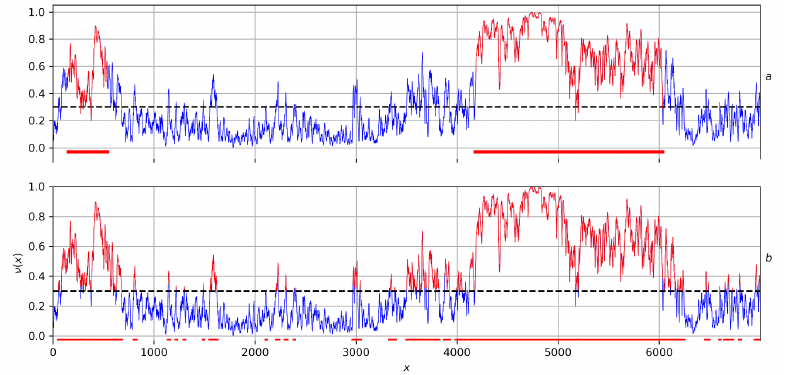
Figure 11. Operation of the FDPS algorithm on a regular grid ( a ). The FDPS algorithm results in two red lines on the horizontal axis, which serve as the bases of the two most significant stochastic heights. Figure ( b ) shows a classic choice with respect to a given level, highlighting many weak